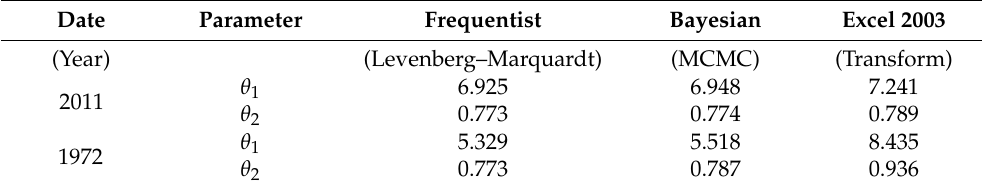
Table 1. Comparison of Frequentist and Bayesian regression results for parameter uncertainty for SOC depth profile (based on parameters 𝜃 (cid:2869) and 𝜃 (cid:2870) in the Power Law function).